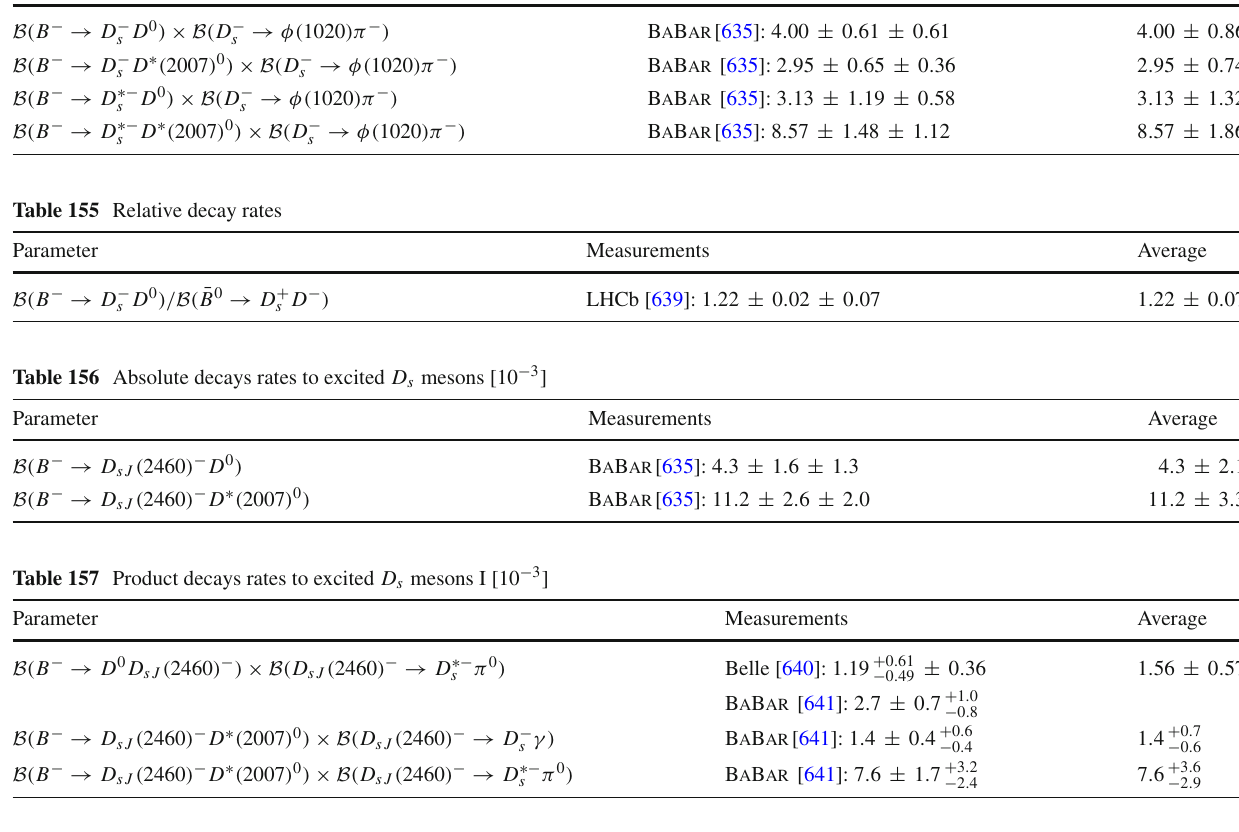
Table 154 Product decays rates to D